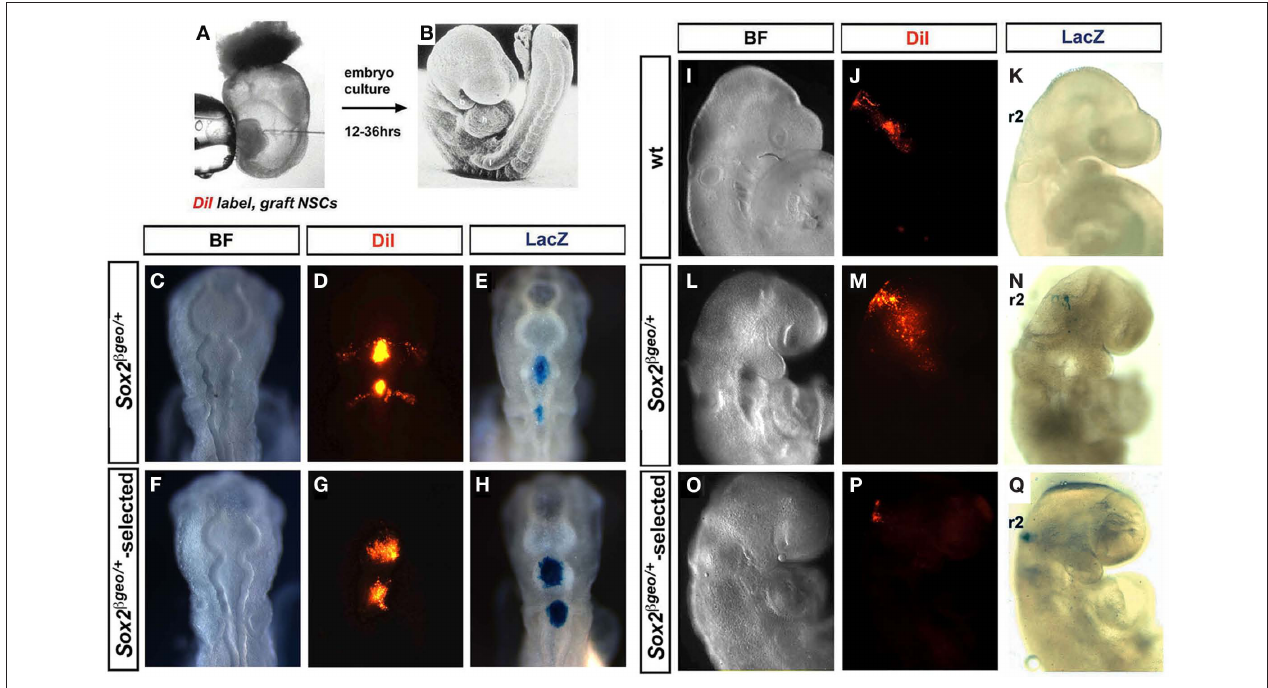
Figure 3 | Sox2 restricts NSC commitment to a cranial NCC fate. Neurospheres were transplanted into the hindbrains of mouse and chick embryos (A,B) which were then cultured for up to 36 h. Transplantation of Sox2 β geo/ + (C–e) and Sox2 β geo/ + -selected (F–H) neurospheres into r2 and r4 of E1.5 chick embryos. Transplantation of wt (i–K) , Sox2 β geo/ + (L–N) , and Sox2 β geo/ + - selected (O–Q) neurospheres into r2 and r4 of E8.5 mouse